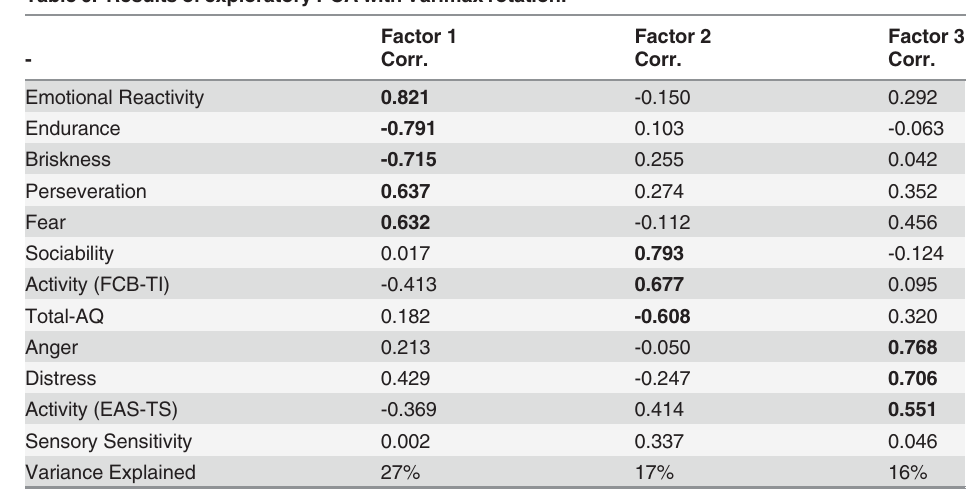
Table 6. Results of exploratory PCA with Varimax